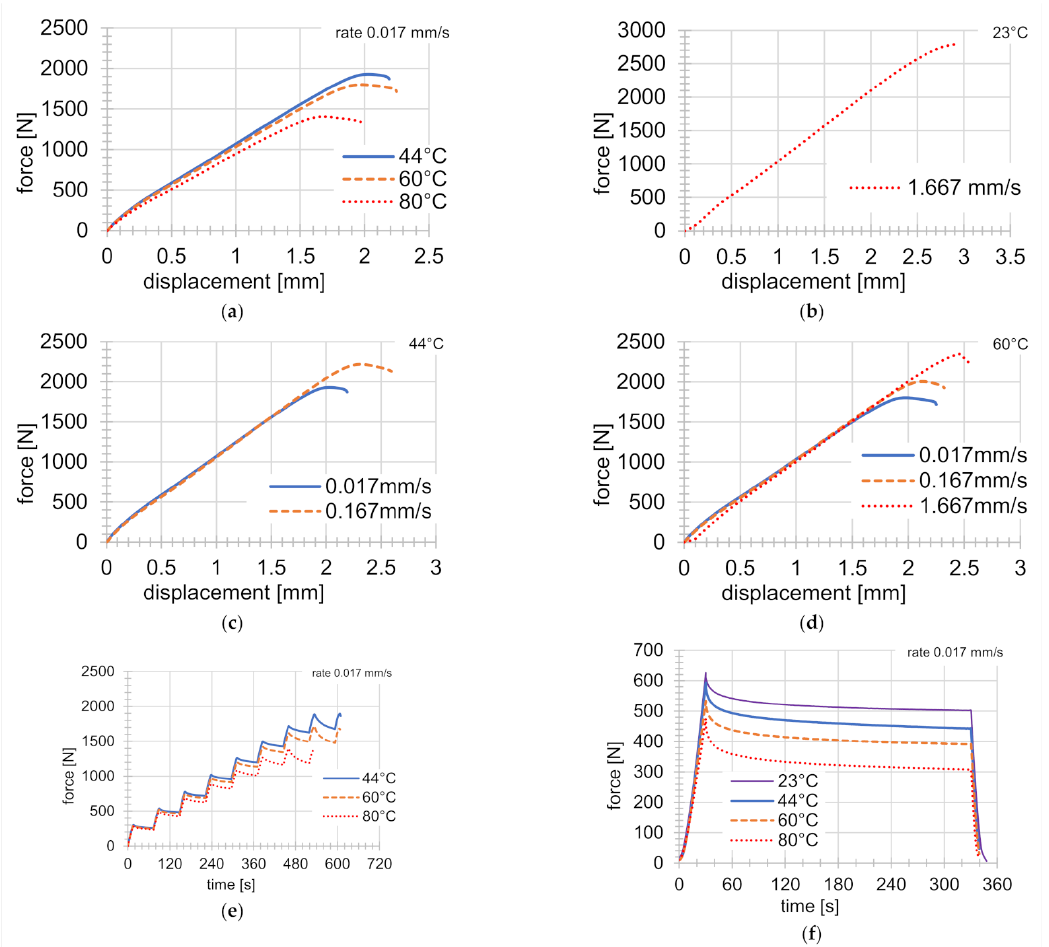
Figure 3. ( a ) Tensile tests at temperatures of 44 ◦ C, 60 ◦ C, and 80 ◦ C, with constant rates of deformation at 0.017 mm s − 1 . ( b ) Tensile tests at 23 ◦ C and at a constant rate of deformation of 1.667 mm s − 1 . ( c ) Tensile tests at a temperature of 44 ◦ C, with two different rates of deformation. ( d ) Tensile tests at 60 ◦ C, with three different rates of deformation. ( e ) Graduated tensile tests under three different temperatures of 44 ◦ C, 60 ◦ C, and 80 ◦ C. ( f ) Indentation tests with time delay at temperatures of 23 ◦ C, 44 ◦ C, 60 ◦ C, and 80 ◦ C, with a constant indenter rate of 0.017 mm s − 1